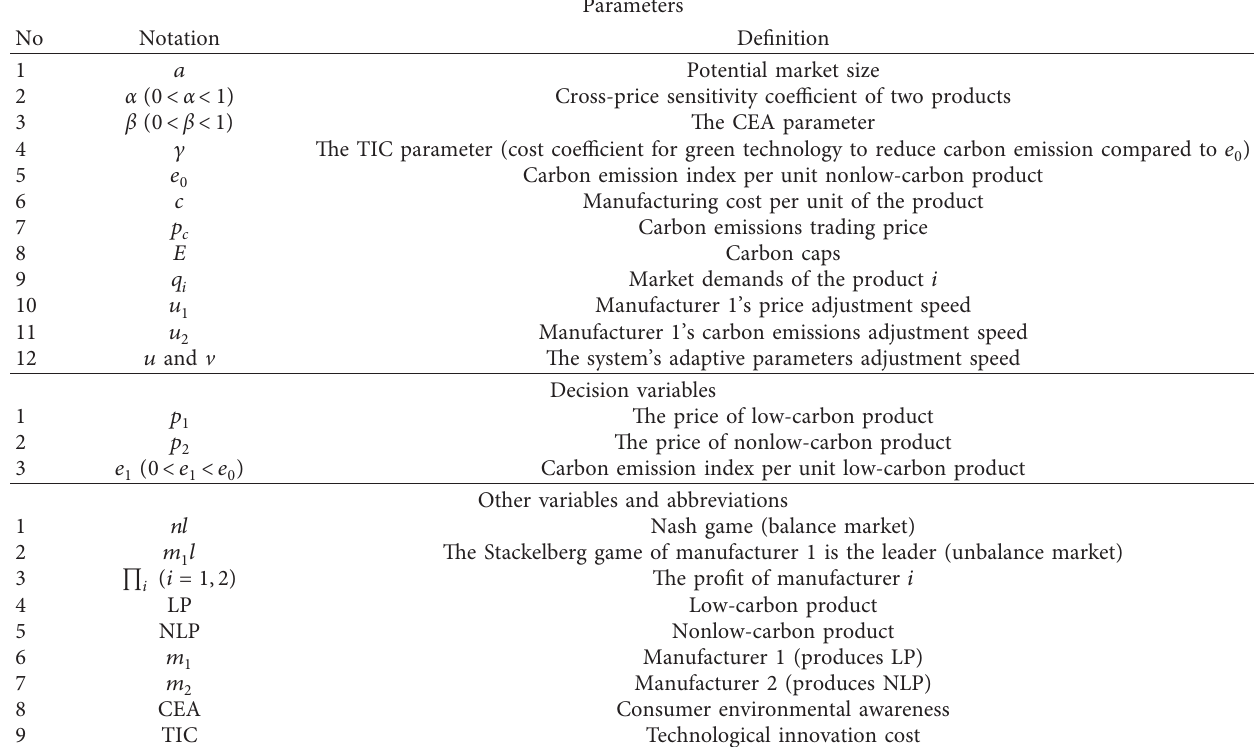
Table 2: Parameters and